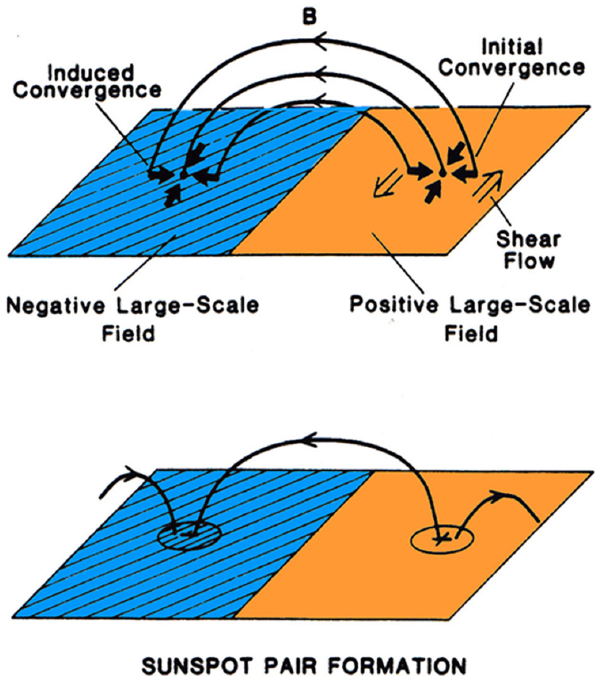
Fig. 4a. Schematic illustration of how a sunspot pair can be formed across two adjacent UM-regions of positive and negative polarities.